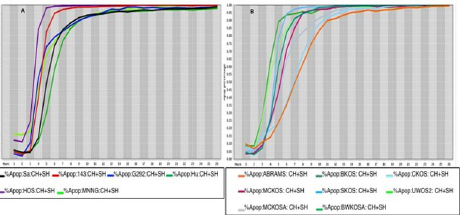
Fig 8. Cell death response curves in human and canine osteosarcoma. 8a Cell death response expressed in percentage of apoptosis in human osteosarcoma cell lines (SaOS- black line, 143B- red line, G292- blue line, Hu03N1- dark green line, HOS- purple line, HOS-MNNG- neon green line) exposed to CT at 20 μ M, HO-3867 at 10 μ M, and SH-4-54 at 5 μ M concentration. 8b Cell death response expressed in percentage of apoptosis in canine osteosarcoma cell lines (ABRAMS- orange line, BKOS- dark green line, CKOS- light blue line, MCKOS- maroon line, SKOS- sky blue line, UWOS-2- neon green line, MCKOSA- gray line, BWKOSA- light green line) exposed to CT at 20 μ M, HO- 3867 at 10 μ M, and SH-4-54 at 5 μ M concentration.